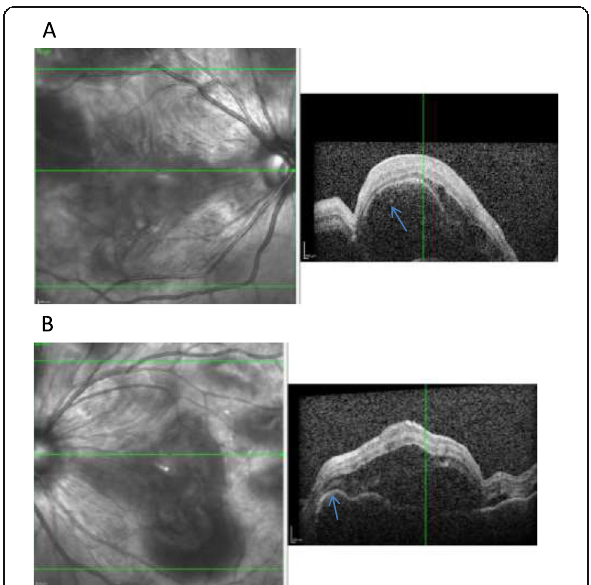
Fig. 2 a SS-OCT Macula of the right eye showing area of serous detachment. b SS-OCT Macula of the left eye showing RPE undulations and subretinal